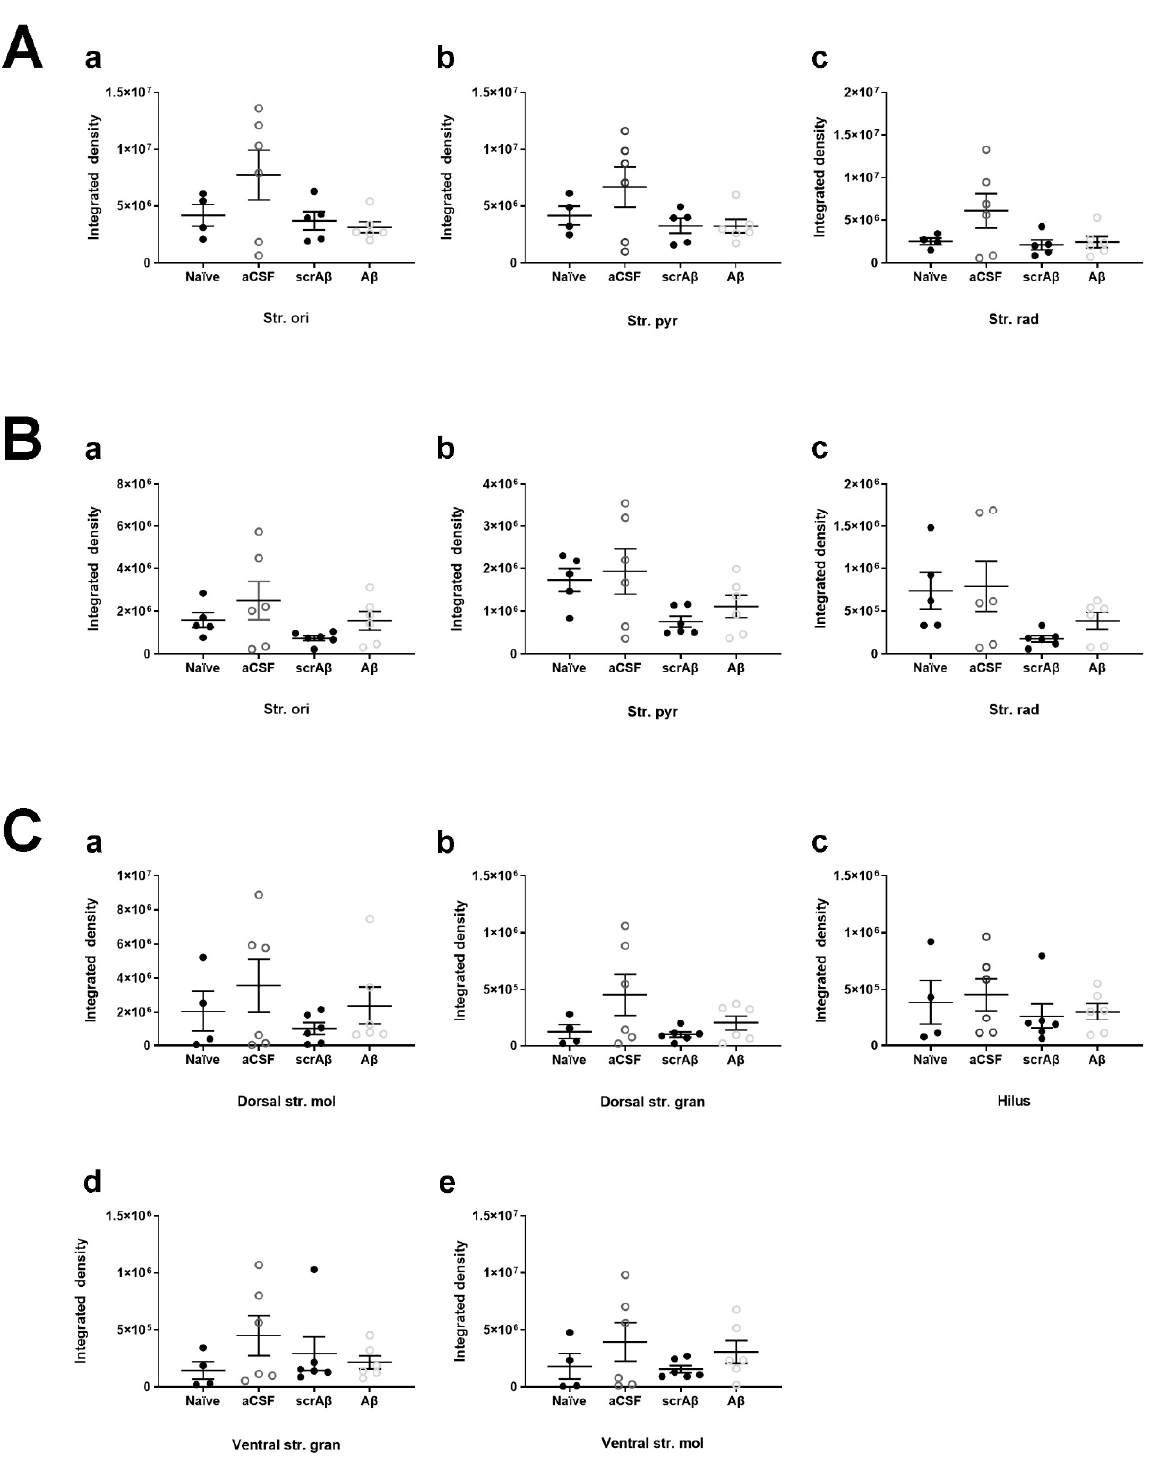
Figure 7. Quantification of KCC2 density in the mouse hippocampus. KCC2 density in the str. oriens (str. ori), str. pyramidale (str. pyr) and str. radiatum (str. rad) of the ( A ) CA1 and ( B ) CA3 regions, and the dorsal and ventral str. moleculare (str. mol), hilus, and dorsal and ventral str. granulosum (str. gran) of the ( C ) DG. Data is expressed as the mean ± SEM. One-way ANOVA with Tukey’s multiple comparisons test, n = 5–6 for each experimental group. Naïve = untreated mice; aCSF = ACSF-injected; A β = A β 1-42 -injected mice; scrA β = scrambled A β 1-42 -injected